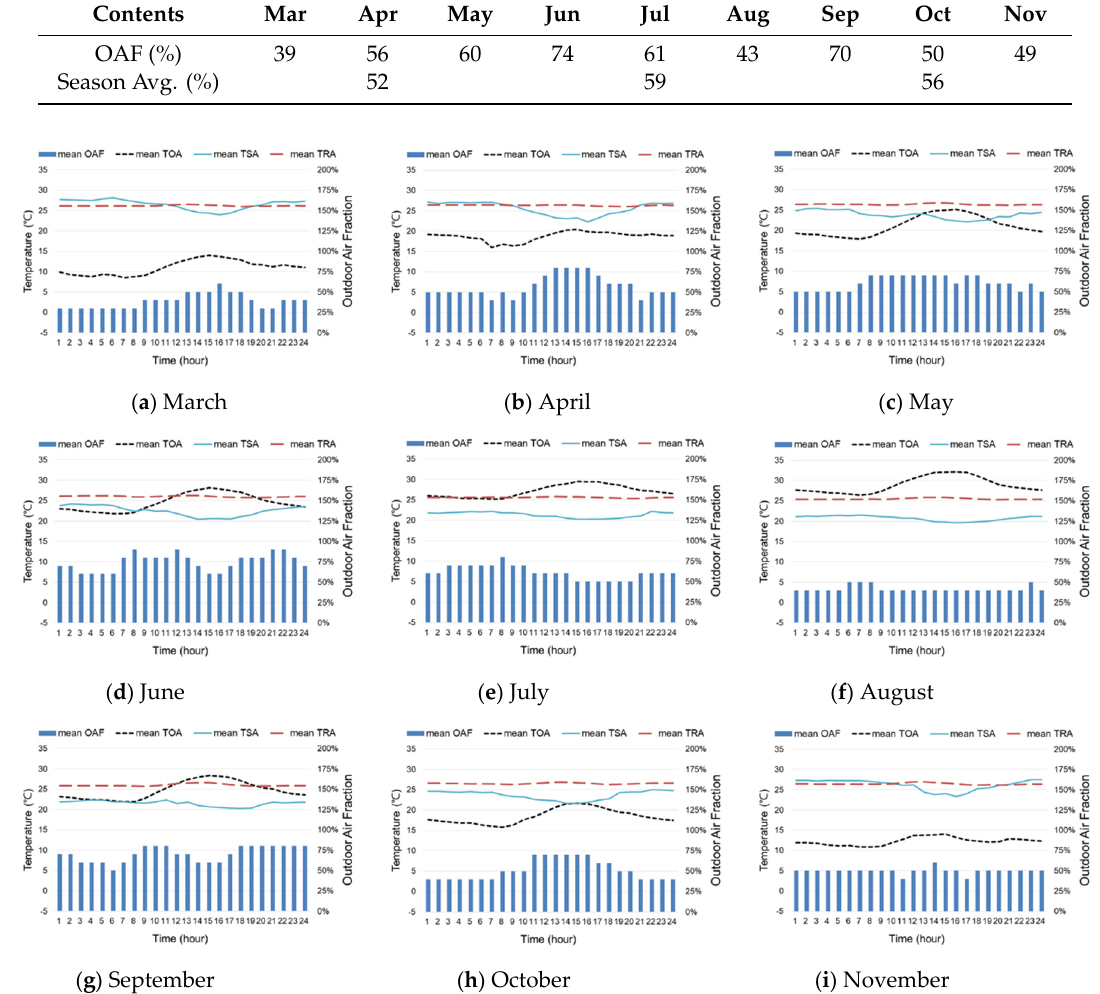
Figure 8. OAF and temperature distribution (March to November).